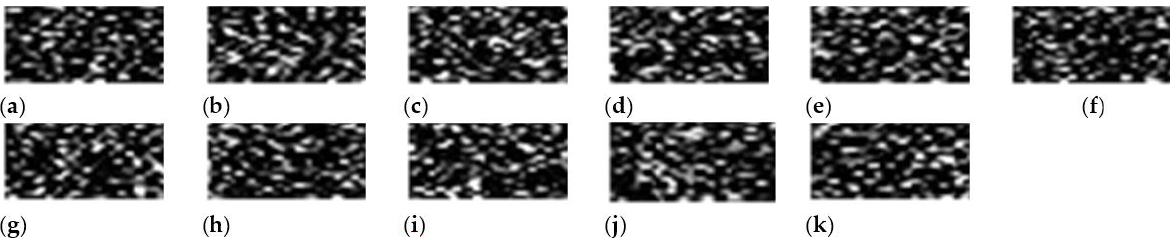
Figure 16. Partial 40 × 20 sample graph without target under the condition of 0 dB SNR, and the units are ( a ) 400th, ( b ) 800th, ( c ) 1200th, ( d ) 1600th, ( e ) 2000th, ( f ) 2400th, ( g ) 2800th, ( h ) 3200th, ( i ) 3600th, ( j ) 4000th, and ( k ) 4400th.